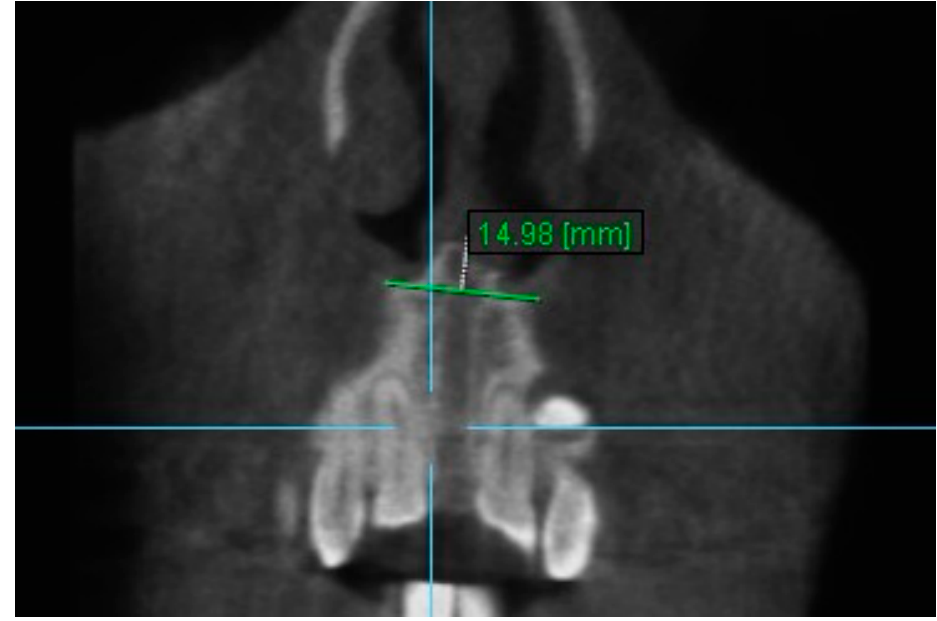
Figure 11. Nasal Floor 9. The measurements used for assessment of the aperture of midpalatal suture were: 10. Aperture of Midpalatal Suture 10: The distance between the inner points of posterior median palatine suture, bilaterally in posterior nasal spine (PNS) (Figure 12).